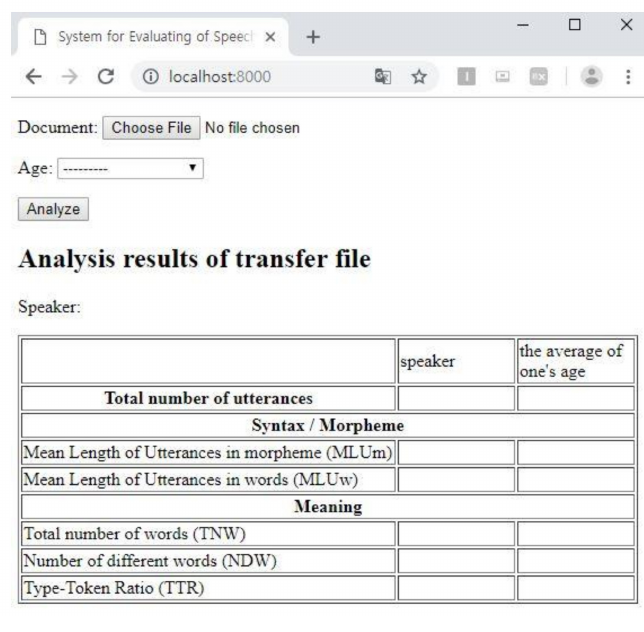
Figure 2. Screen shot of the client part.